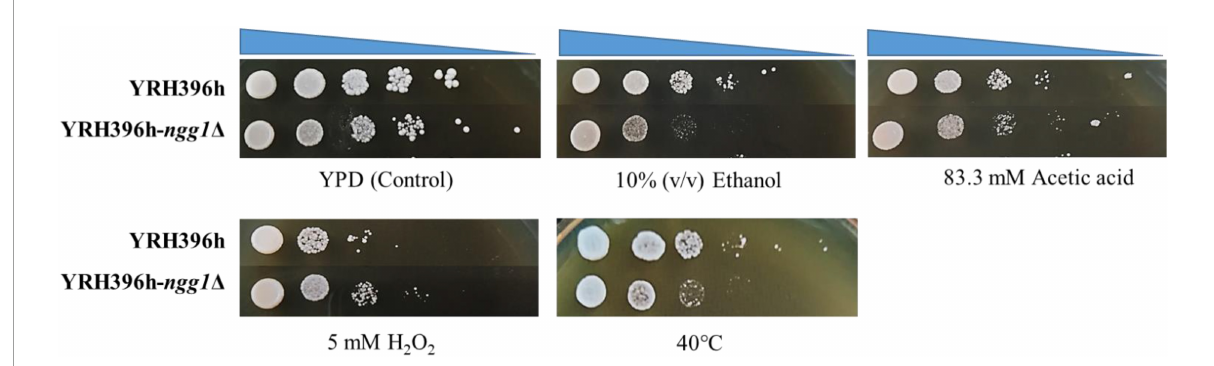
FIGURE2 Stress tolerance of the NGG1 deletion mutant of S cerevisiae YRH396h based on the genetic background of S. cerevisiae YB-2625. Stress tolerance of the yeast strains was evaluated by spot assay. The initial OD 600 of all yeast strains was adjusted to 1.0, and yeast cells were diluted by ten-fold serially. YPD agar medium without inhibitors was used as a control medium. Stress tolerance of the yeast strains was tested in YPD agar medium supplemented with 10% (v/v) ethanol, 83.3 mM acetic acid, or 5 mM H 2 O 2 , respectively. Except for thermal tolerance test at 42 ◦ C, the yeast strains were all cultivated at 30 ◦ C.